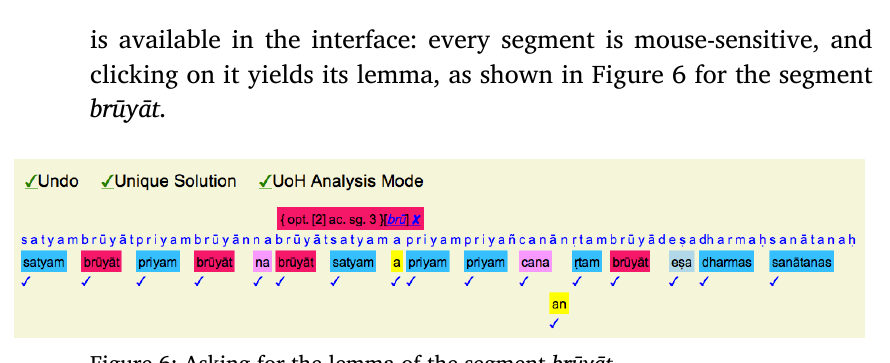
Figure 6: Asking for the lemma of the segment brūyāt Note that, in this lemma, the root brū is itself mouse-sensitive; it is a hyperlink to its lexical entry, allowing access to its meaning. We provide two aligned digital lexicons, our original Sanskrit-to-French Heritage dictionary, and also the more complete classical Sanskrit- to-English Monier-Williams (MW) dictionary (Monier-Williams et al. 1899). 5 Thus annotators have all available information at their dis- posal at any point, but with minimal cluttering of the